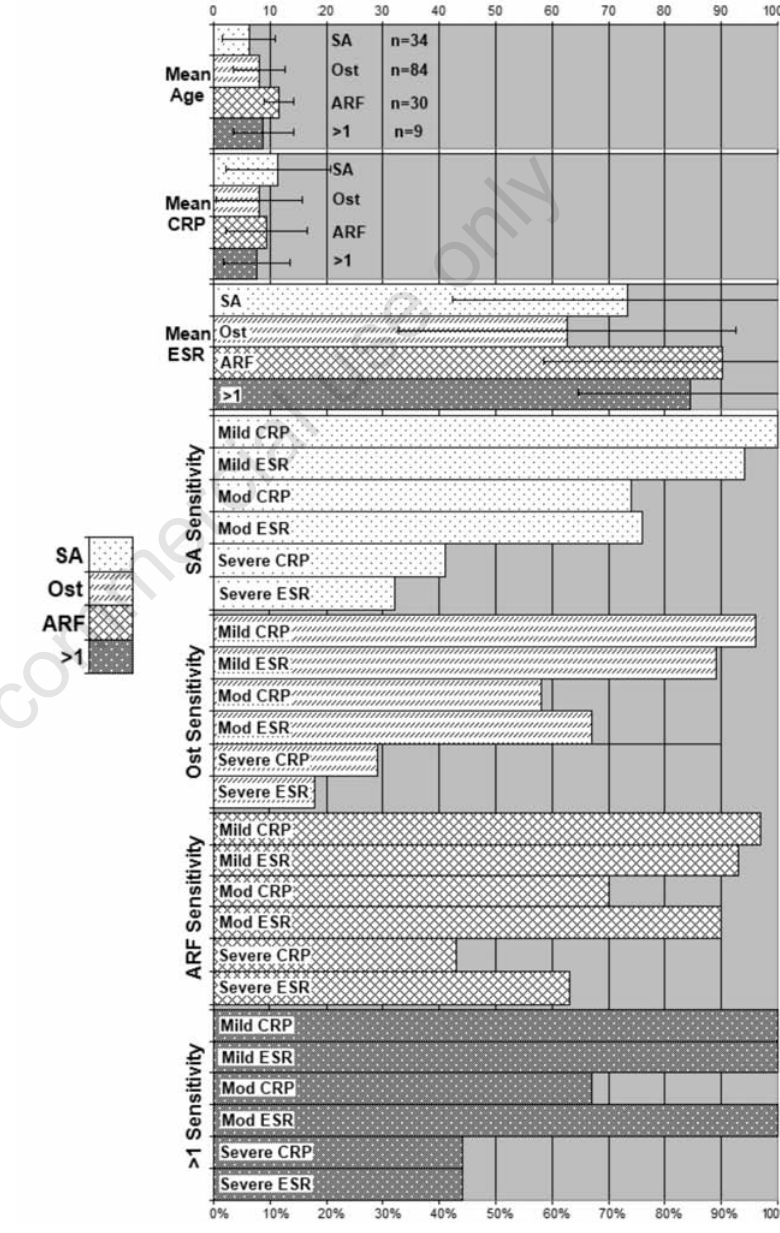
Figure 1. Mean age, CRP (mg/dL), and ESR (mm/hr) in 34 patients with septic arthritis, 84 patients with osteomyelitis, 30 patients with acute rheumatic fever, and 9 patients with